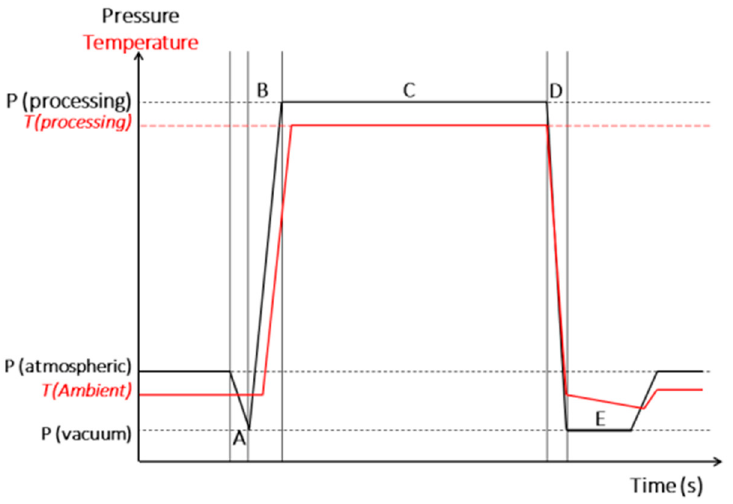
Figure 1. Schematic time-pressure profiles of a DIC processing cycle.